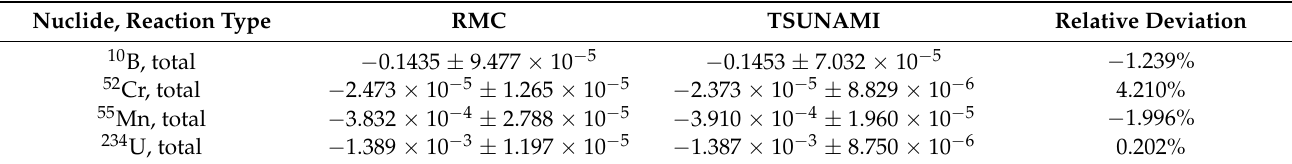
Table 8. Sensitivity of total reaction